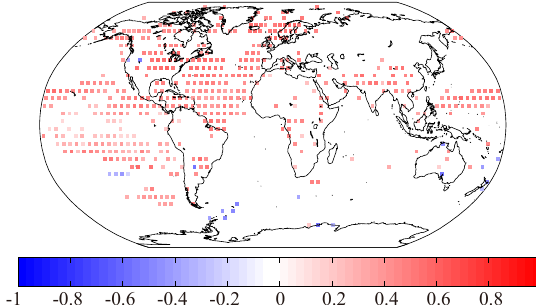
Fig. 2. Correlation maps between Greenland Summit temperatures Figure 2. and grid temperatures over the period. Top panel: correlation map in the period between 1852 and 2010 with the observation–model- based Summit and grid temperatures (annual resolution) by Box et al. (2009). Parentheses indicate correlation coefficients between the Summit temperatures (Kobashi et al., 2011) and δ 18 O ice from six ice cores (Vinther et al., 2009) over the past 4000yr with p =0.04 for Dye3, p =0.02 for GISP2, p > 0.1 for GRIP, p =0.01 for NGRIP, p =0.05 for Renland, and p > 0.1 for Agassiz. Mid- dle panel: correlation map between Greenland Summit temperature (Box et al., 2009) and global grid temperatures for the period from 1880 to 2010 (Hansen et al., 2010). Only grids with > 90% confi- dence are shown (two-sided tests). Bottom panel: correlation map between Greenland Summit temperature (Kobashi et al., 2011) and global grid temperatures (Mann et al., 2009) for the period from 1200 to 2010. Only grids with > 90% confidence are shown (two- sided